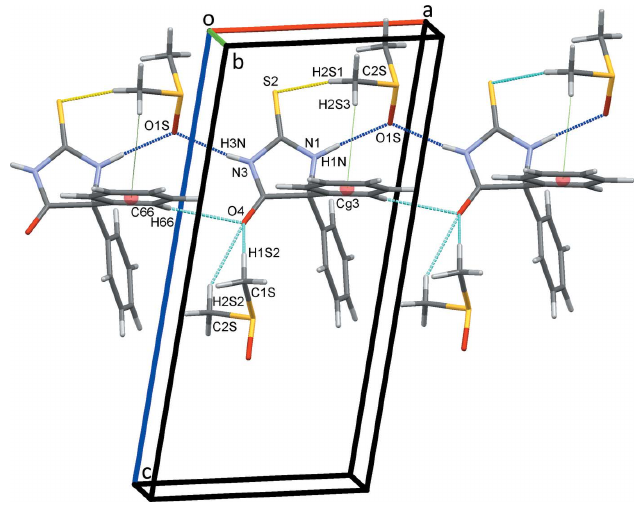
Figure 2 Rows of the thiohydantoin and DMSO solvent molecules formed along a . In Figs. 2 and 3, N—H (cid:2)(cid:2)(cid:2) O, C—H (cid:2)(cid:2)(cid:2) O and C—H (cid:2)(cid:2)(cid:2) S hydrogen bonds are shown as dark-blue, light-blue and yellow dashed lines, respectively. C—